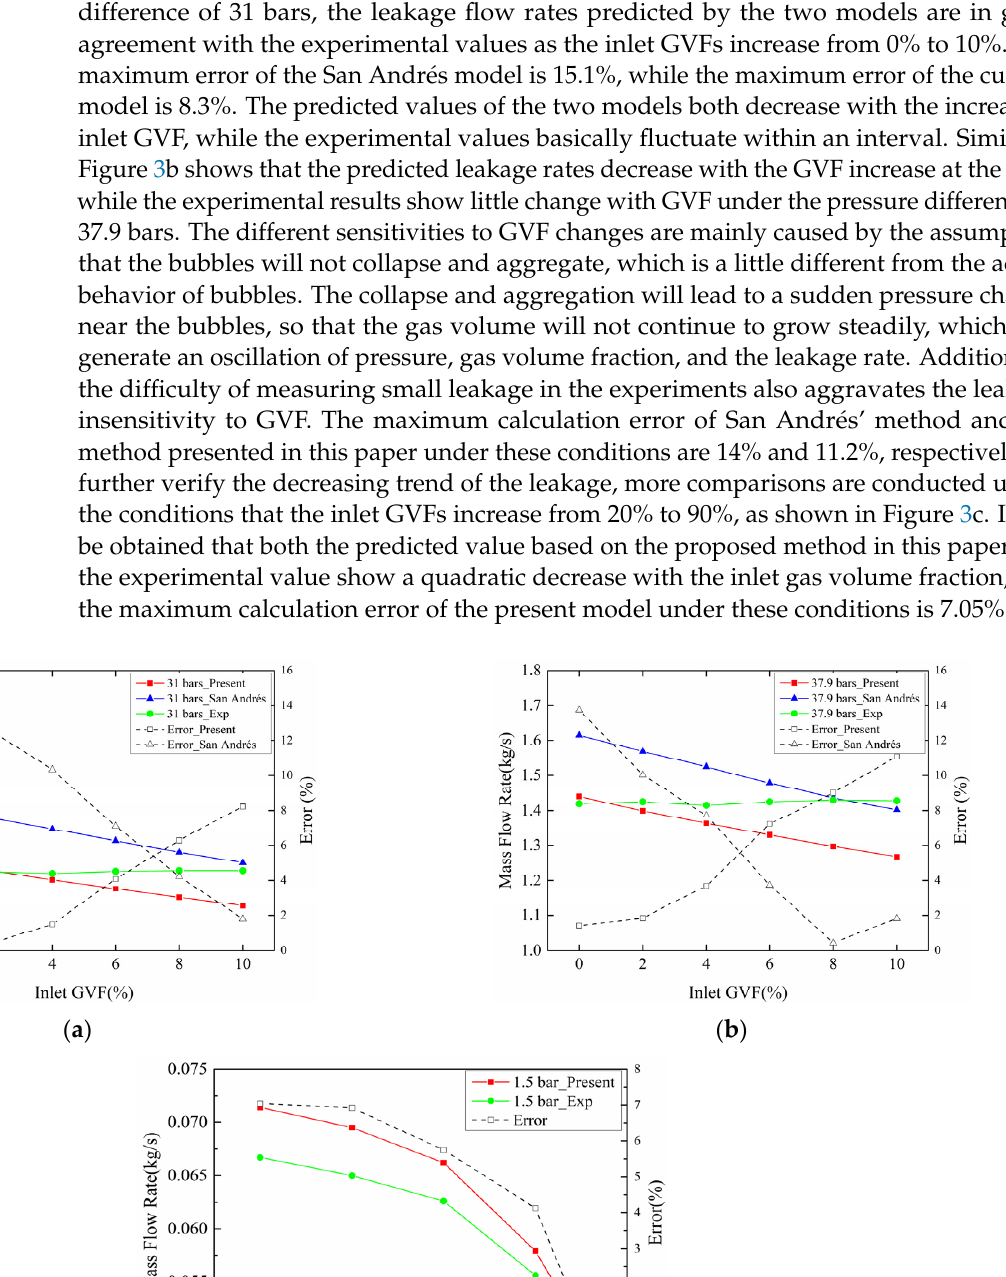
Table 1. Seal geometrical parameters and operational conditions [28].